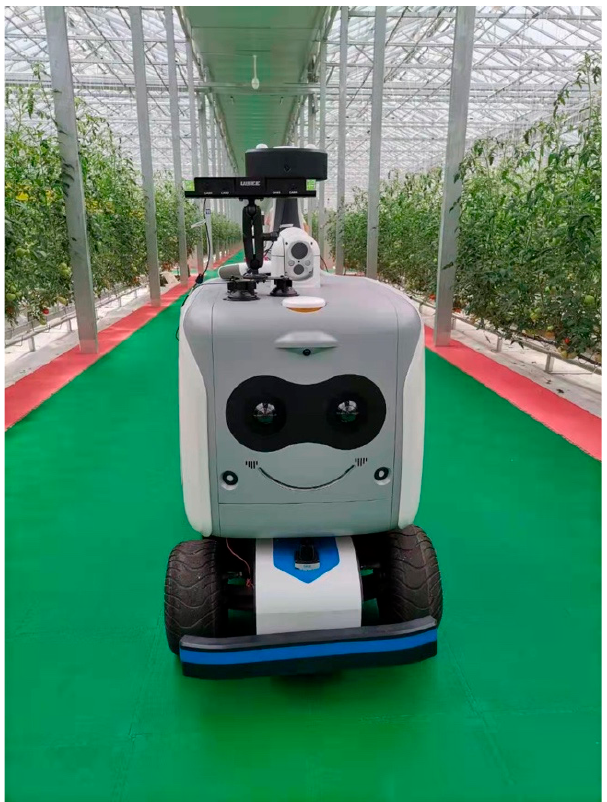
Figure 2. In this experiment, an inspection robot is used to detect and count the growth state of plants.